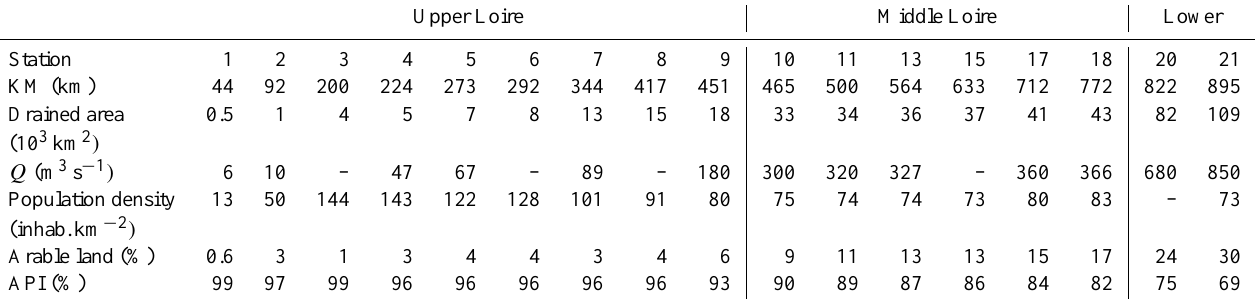
Table 1. Loire main stem stations characteristics. Kilometer marker (KM): distance from headwaters; Drained area; Q : average an- nual discharge; population density in 2008; arable land as percentage of the drained catchment; API: agricultural pressure indica- tor = (pasture + forest)/(pasture + forest + arable land) expressed in percentage. See Sect. 1.2. for source information.